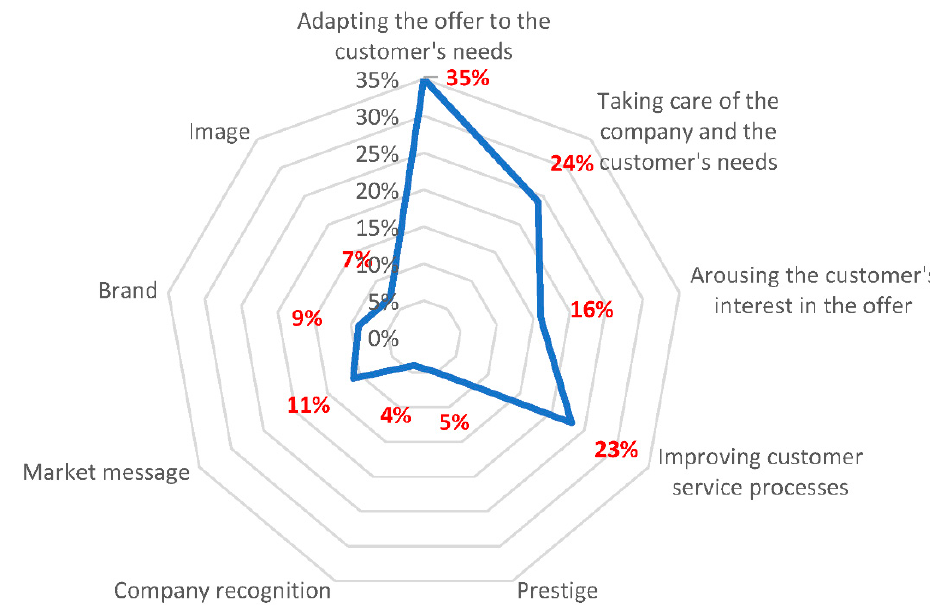
Figure 2. Answers to the question: What is quality for you?